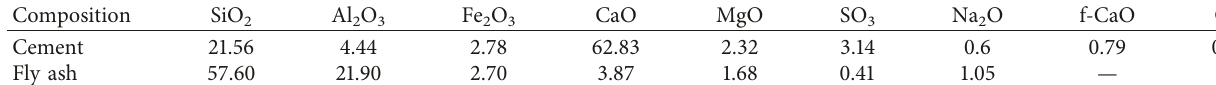
Table 1: Chemical compositions of cement and fly ash.